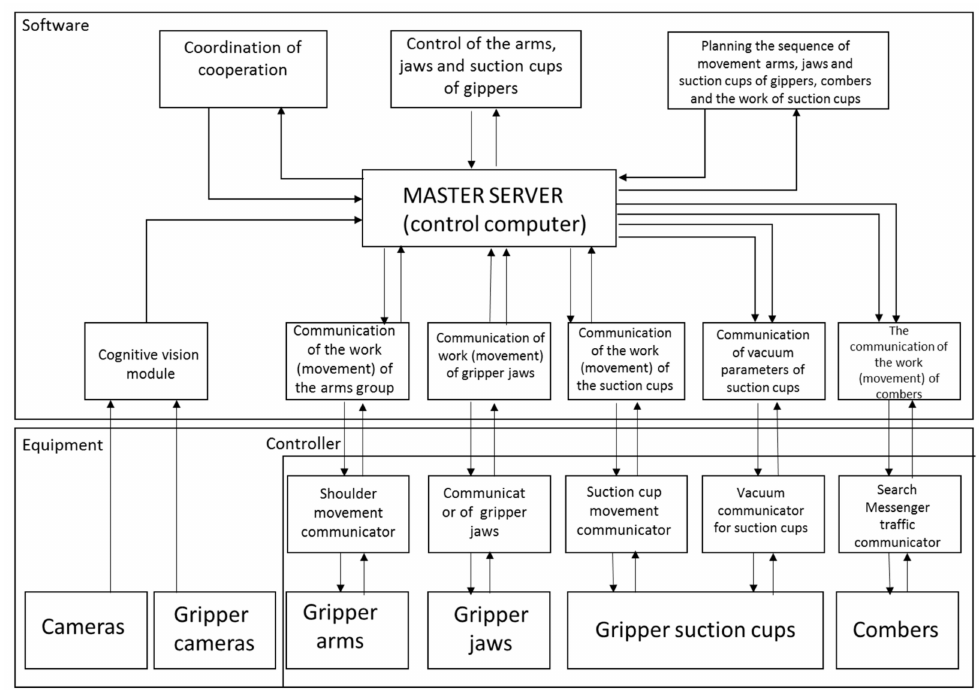
Figure 3. Functional diagram of the control system for the working section of the strawberry-picking